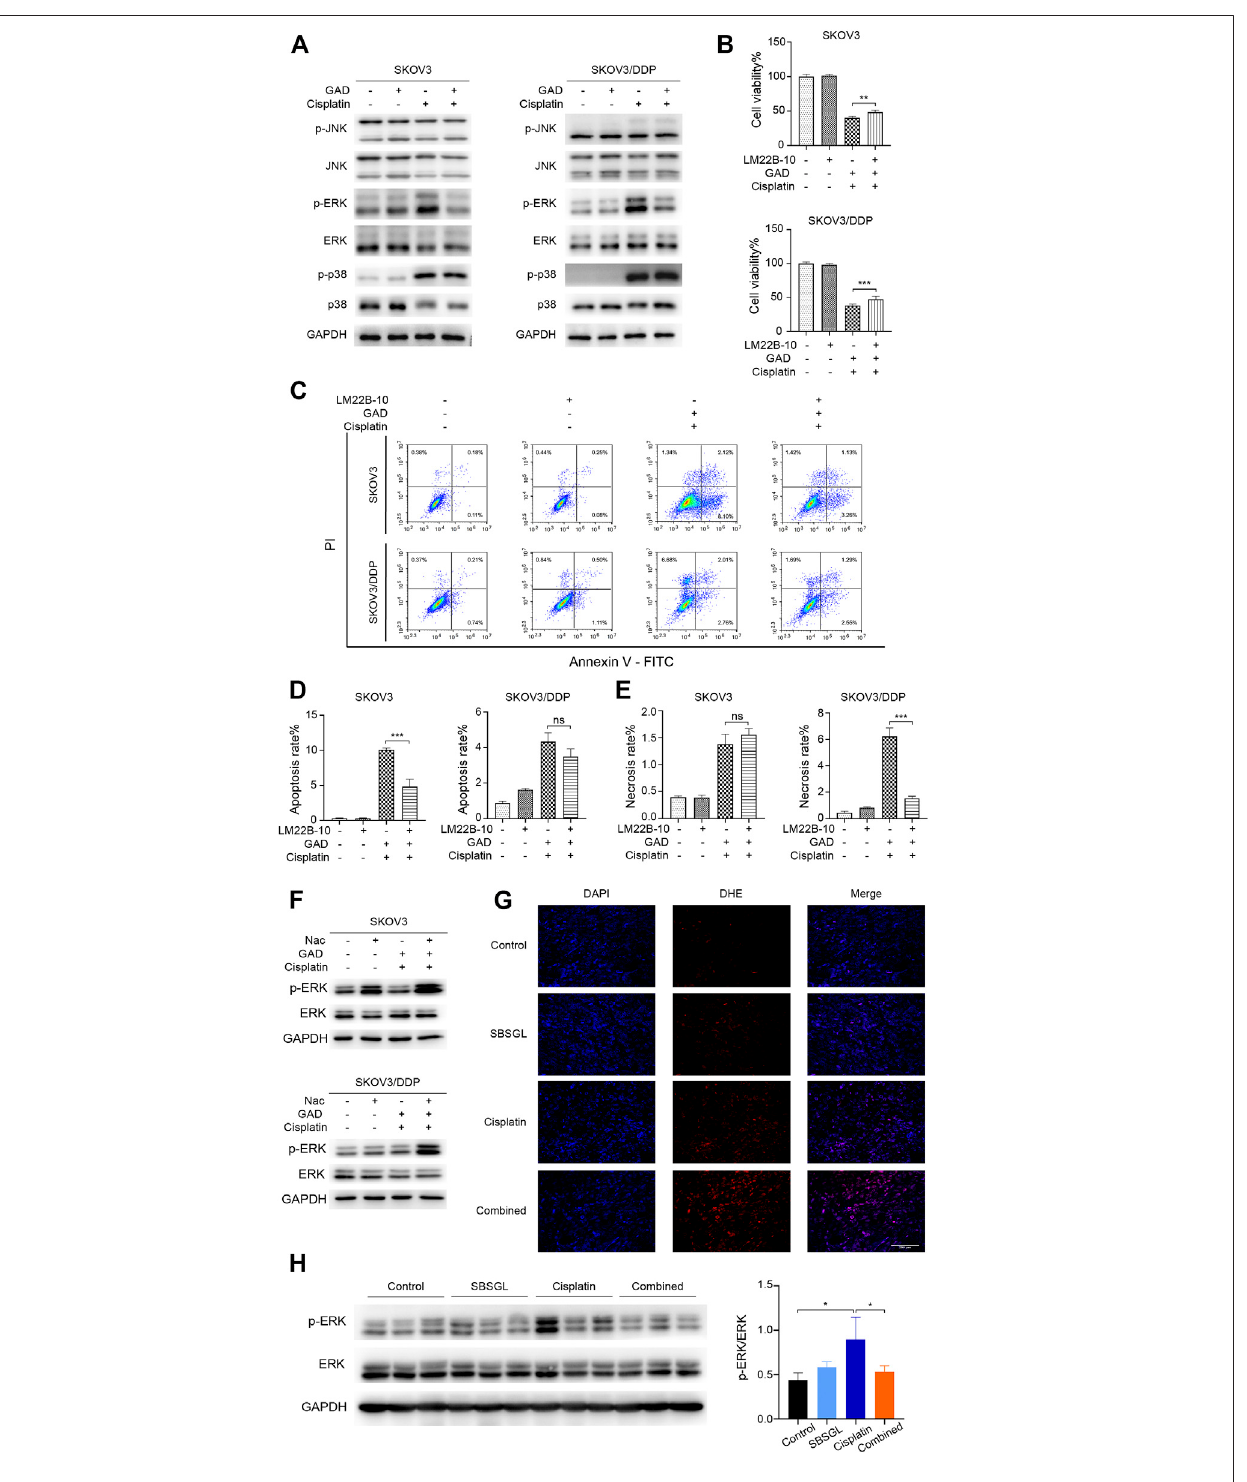
FIGURE 5 | ROS/ERK signaling mediated the combination effect of GAD and cisplatin in SKOV3 and SKOV3/DDP. (A) The phosphorylated protein expression of MAPK signal pathways in SKOV3 and SKOV3/DDP treated with GAD (200 μ M) and cisplatin (40 μ M for SKOV3 and 200 μ M for SKOV3/DDP) alone and their combination for 24 h. To explore the role of ERK signaling, SKOV3 and SKOV3/DDP were pretreated with the ERK activator, LM22B-10 (20 μ M) for 6h, followed by the combination of GAD and cisplatin for 24 h. The cell viability (B) and death (C) were detected by the CCK-8 assay and Annexin V/PI assay. (D,E) The quantitative analysis of cell apoptosis and necrosis. (F) The protein expression of p-ERK in SKOV3 and SKOV3/DDP incubated with the combination of GAD and cisplatin with or without 10 mM NAC for 24 h. (G) The DHE fl uorescence (red) in tumor tissues. Cell nuclei were detected by DAPI (blue). (H) The protein expression of p-ERK in tumor lysate. Data are presented as the mean ± SD ( n = 3). *** p < 0.001, ** p < 0.01, * p < 0.05, ns, no statistical signi fi cance.